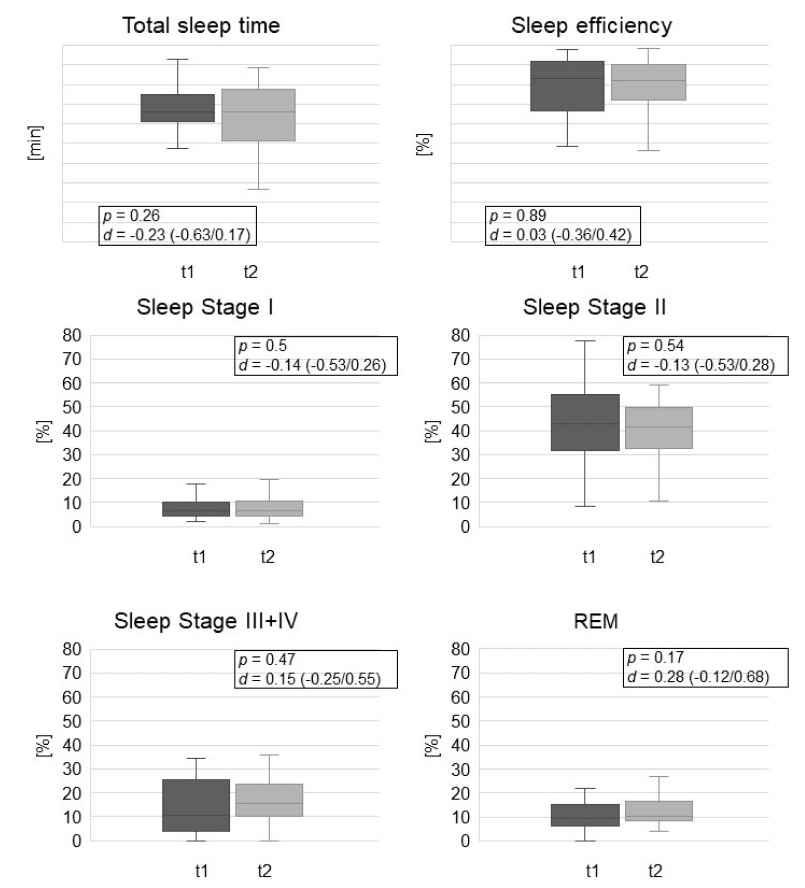
Figure 3. A series of boxplots illustrating the polysomnographic findings prior to NIV (t1) and at 3 months follow-up (t2) in the whole study population ( n = 25). Notes: p -value of 2-tailed t -test; data for Cohan’s d are displayed with 95% confidence intervals in brackets. Abbreviations: d : Cohan’s d ; m: minutes; REM: rapid eye movement.